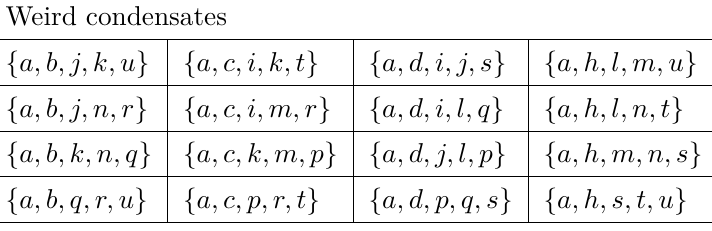
Table 11 . 16 weird condensates in D ( D 4 )